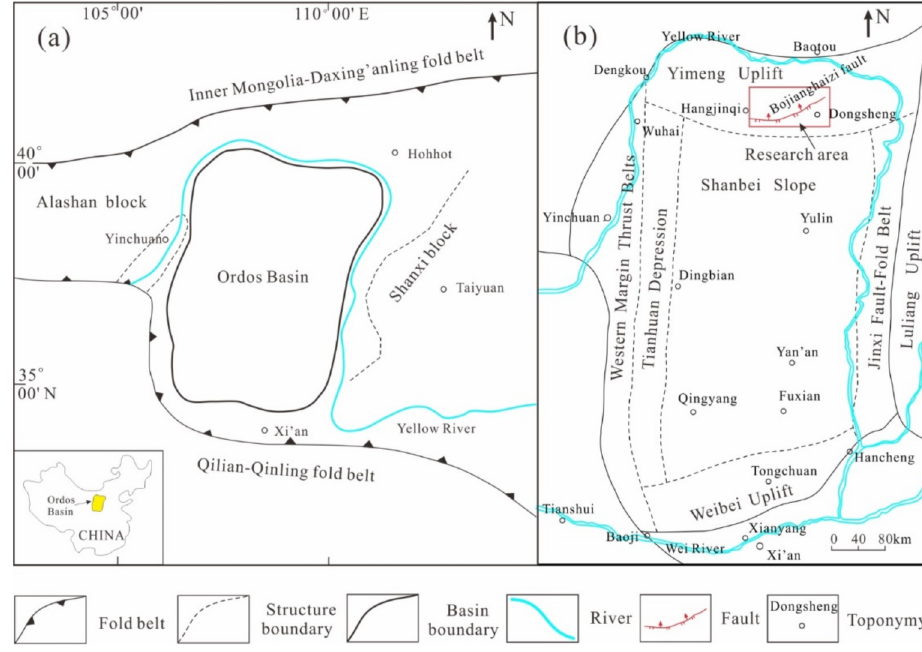
Figure 1. ( a ) Regional tectonic setting of the Ordos Basin; ( b ) Tectonic division map of Ordos Basin (modified after